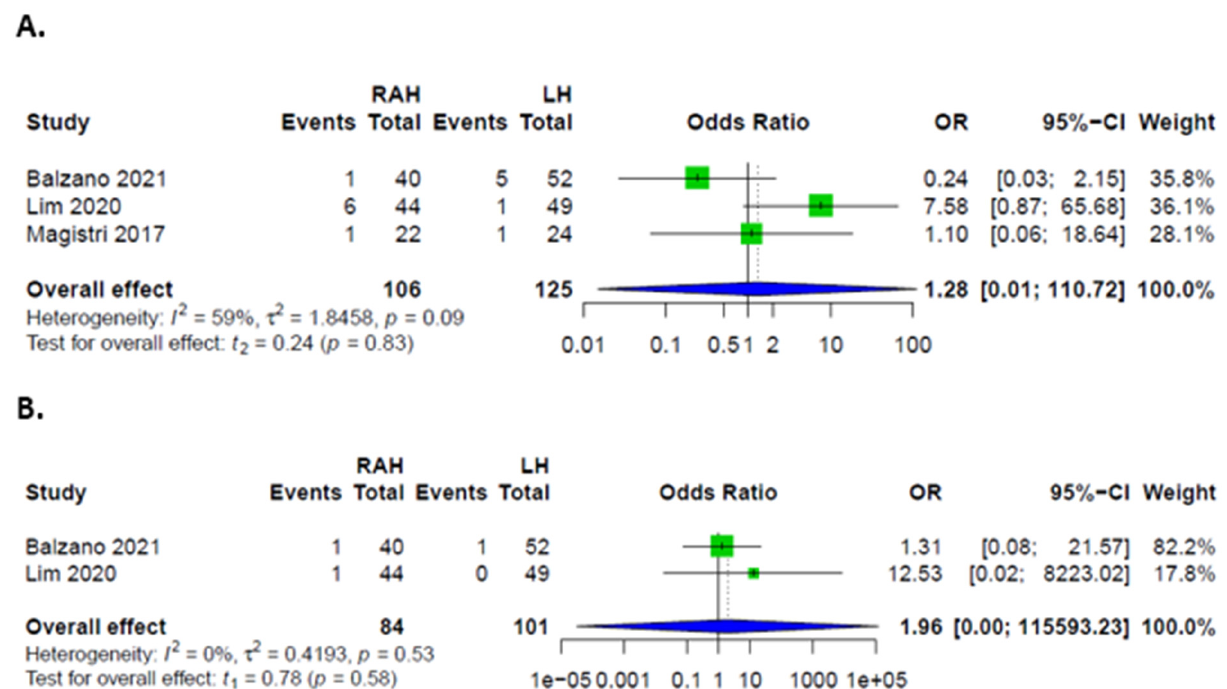
Figure 5. Forest plots for additional interventions; ( A ) Intraoperative transfusions in patients un- dergoing RAH and LH; ( B ) Repeat surgeries in patients after RAH and LH.